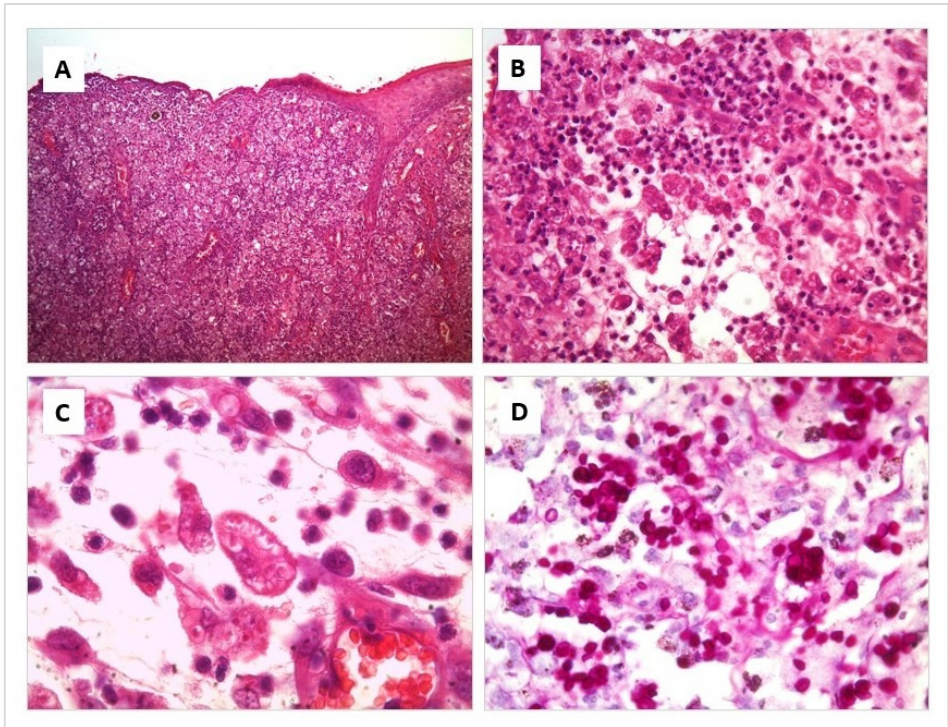
Figure 2. Histological section of a skin lesion from a cat with Sporotrichosis. Hematoxylin-eosin ( A – C ) and Periodic acid-Shiff ( D ) stain. ( A ) Diffuse pyogranulomatous inflammation is present throughout the skin layers. ( B ) Multiple foci of necrosis are surrounded by numerous macrophages, intermingled with neutrophils. ( C ) Round to elongated yeasts 2 to 3 μ m in diameter are present in profusion, both free and within the cytoplasm of macrophages. ( D ) Numerous yeasts with frequent budding figures can be seen, corresponding to Sporothrix spp.